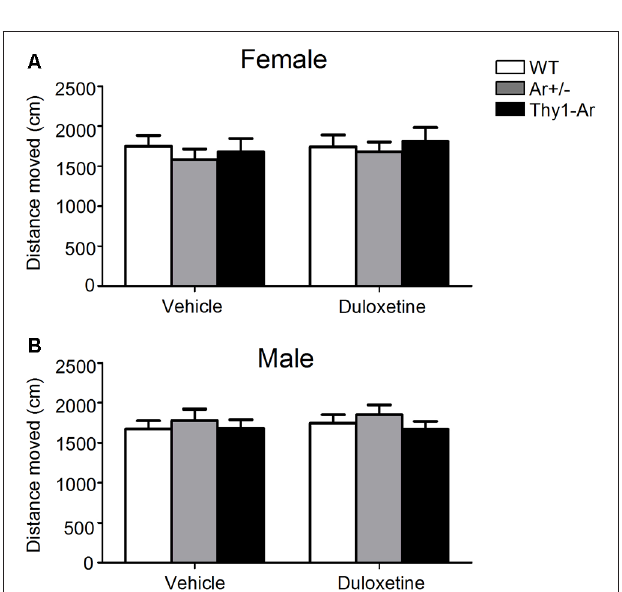
FIGURE 2 | Duloxetine do not affect locomotor activity in both male and female mice in all three genotypes. The distance moved in the spontaneous locomotor activity of three genotype in female mice (A) and male mice (B) treated by duloxetine showed no differences in all three genotype treated by vehicle or duloxetine. n = 6–7